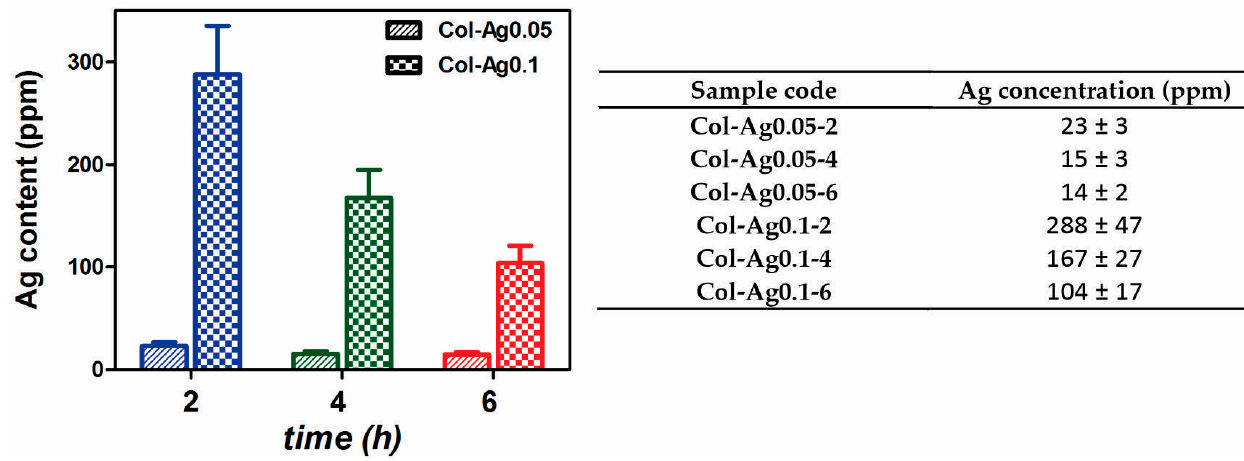
Figure 5 . Silver content in 3D-printed Col-Ag0.05 and Col-Ag0.1 scaffolds, after 2 h, 4 h, and 6 h of UV irradiation, measured by Atomic Absorption spectroscopy. UV irradiation, measured by Atomic Absorption